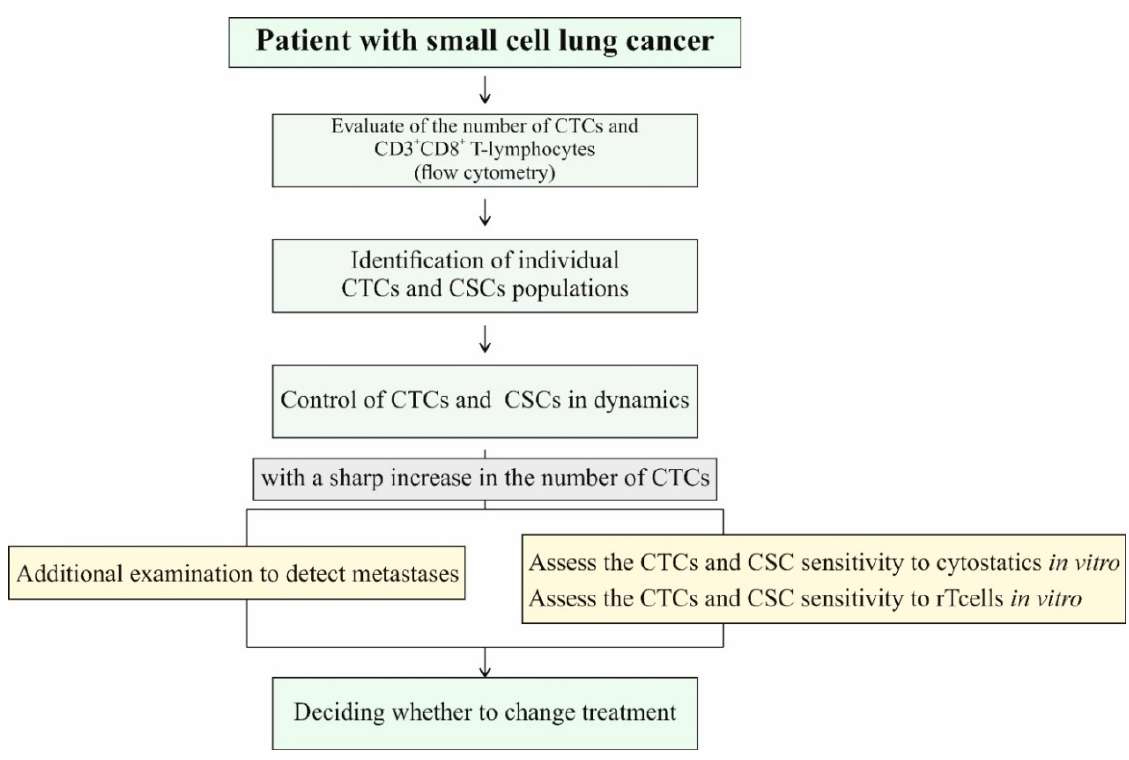
Figure 19. Algorithm for dynamic monitoring of the effectiveness of the treatment.